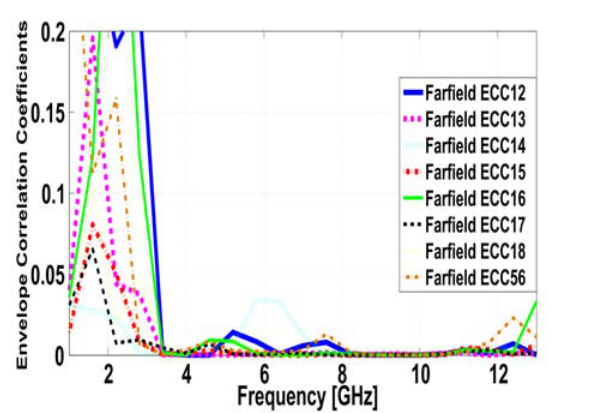
FIGURE. 12 measured envelope correlation